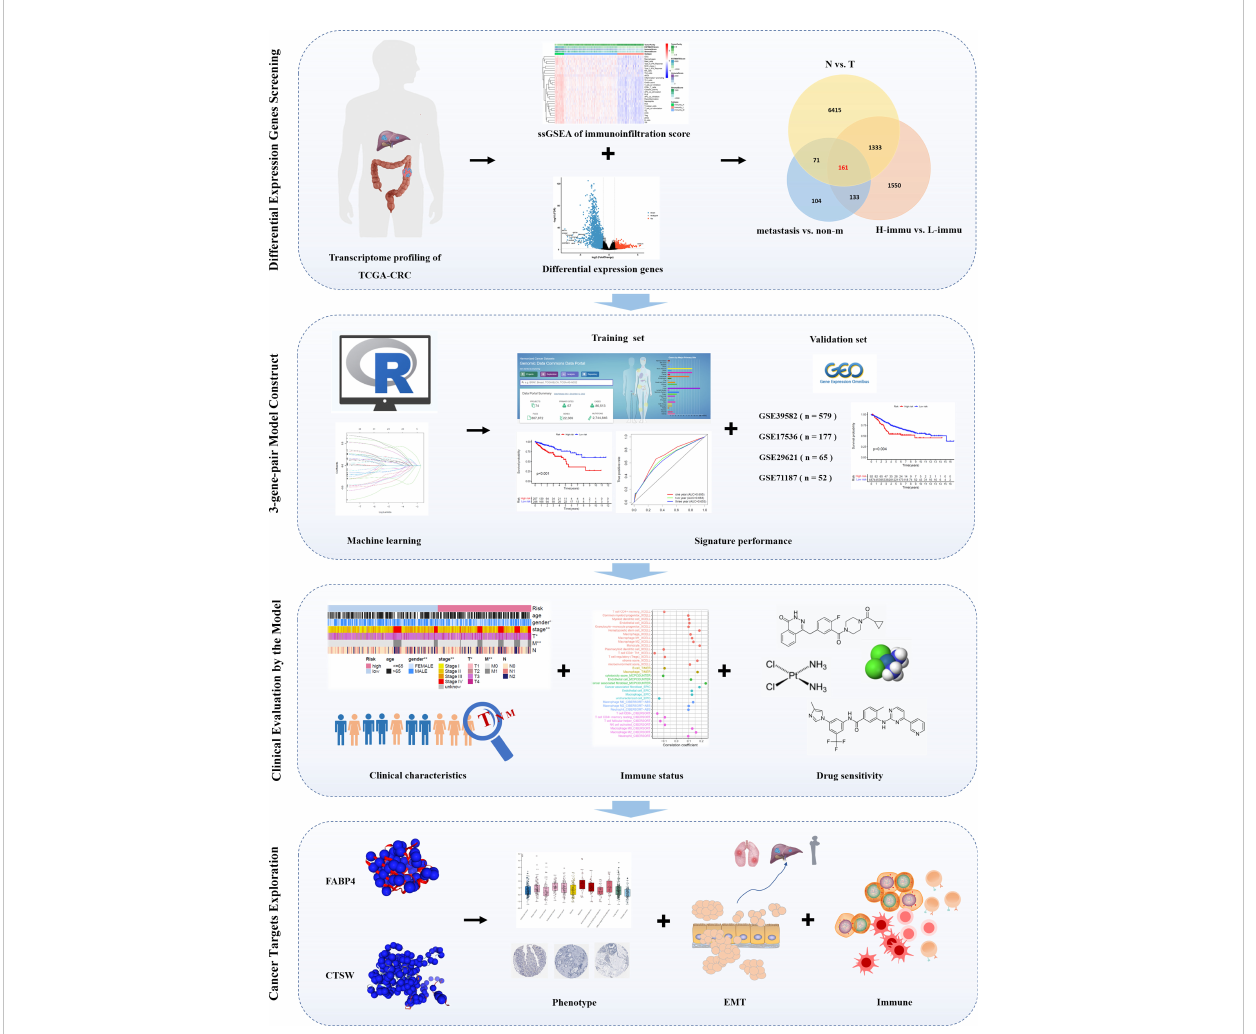
FIGURE 1 Flowchart of the study. First, we screened the TCGA-CRC database for differentially expressed genes associated with immunity and metastasis; second, we paired the differentially expressed genes and performed machine learning to fi t a prognostic signature containing three gene pairs for prognostic validation in the training set and four independent validation sets; third, we explored the correlation between the prognostic signature and clinicopathological characteristics, immune in fi ltration, and drug sensitivity; fi nally, we focused on the role of two genes, FABP4 and CTSW